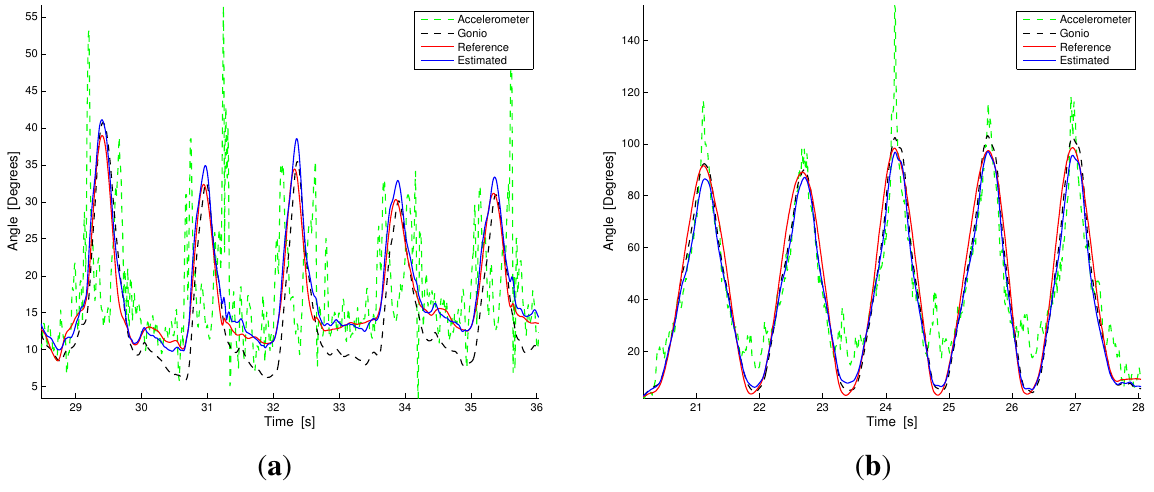
Figure 7. Signal comparison between the angle reconstruction by the accelerometers (green dotted line), the goniometer (black dotted line), the hybrid system (accelerometer + goniometer, blue solid line) and the reference measurement. ( a ) Walking; ( b ) Fast